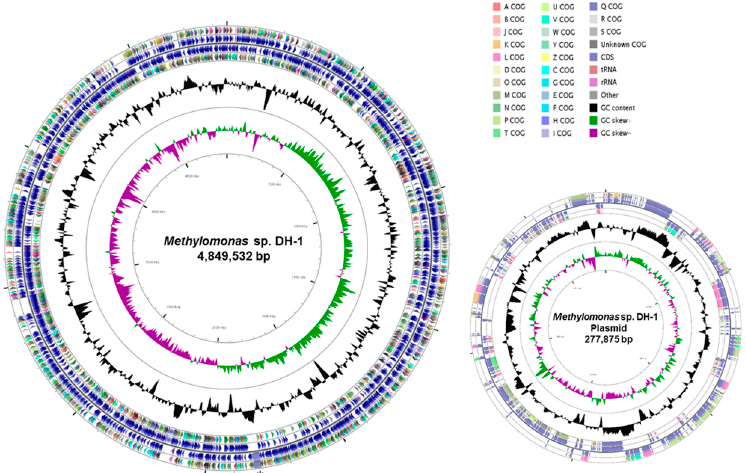
Figure 1. A circular representation of the Methylomonas sp. DH-1 chromosome and plasmid. The rings represent (from inner to outer) the nucleotide position ruler, GC skew, %GC, coding sequences (CDSs) transcribed in the counterclockwise direction, and the clockwise direction, respectively. The CDSs are colored according to the assigned clusters of orthologous genes (COG) classes. The image was rendered using the CGView server (http://stothard.afns.ualberta.ca/cgview_server/).